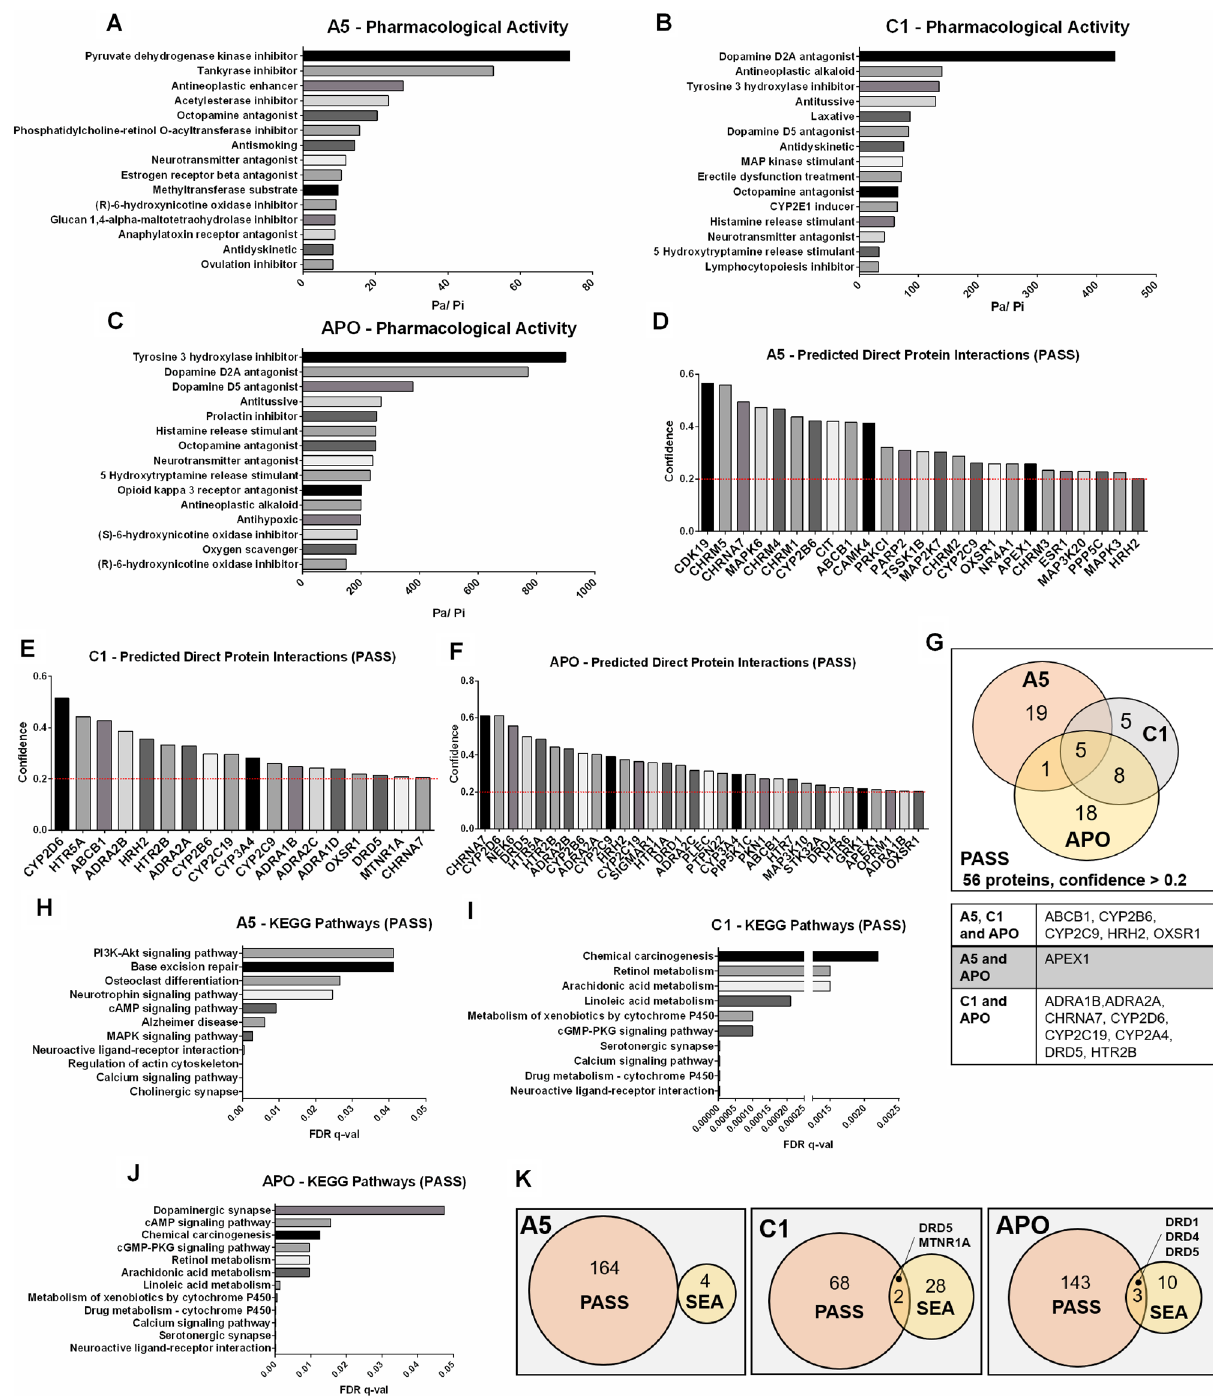
Figure 4. In silico predictions of pharmacological activity and target proteins for the aporphine and isoquinoline derivatives. Prediction of Activity Spectra for Substances (PASS; http:// way2d rug. com/ PassO nline) identified the predicted pharmacological activity of tested compounds ( A ) A5, ( B ) C1 and ( C ) APO. The data were represented as the ratio of probable activity (Pa) per probable inactivity (Pi) for each pharmacological activity. Representation of the PASS predicted proteins with confidence > 0.2 interacting with ( D ) A5, ( E ) C1 or ( F ) APO. ( G ) Distribution of the 56 predicted proteins through PASS (confidence > 0.2) interacting with A5, C1 or APO. The table lists the common interacting proteins for A5, C1 and APO (ABCB1, CYP2B6, CYP2C9, HRH2 and OXSR1); A5 and APO (APEX1); C1 and APO (ADRA1B, ADRA2A, CHRNA7, CYP2D6, CYP2C19, CYP2A4, DRD5 and HTR2B). Representation of the significant KEGG pathways identified through the STRING database related to the PASS predicted proteins interacting with ( H ) A5, ( I ) C1 and ( J ) APO. ( K ) Distribution of the common predicted proteins interacting with A5, C1 and APO based on PASS and Similarity Ensemble Approach